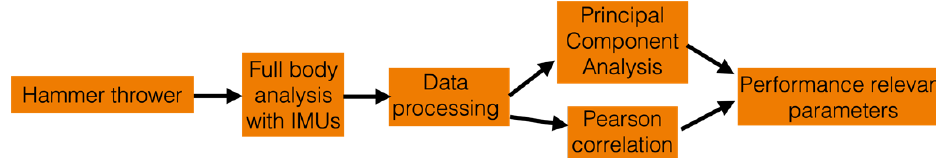
Figure 1. Flow-chart diagram for the main structure of the paper.